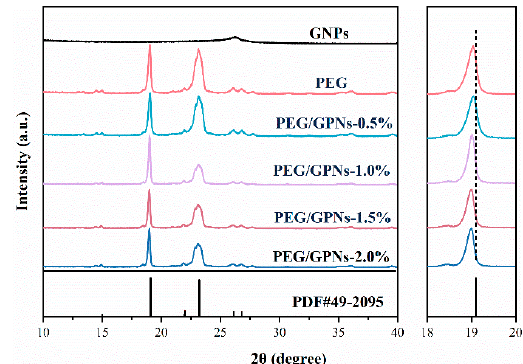
Figure 3. X-ray diffraction (XRD) patterns of GNPs, pure PEG and PEG/GNPs composites with the different contents of GNPs.